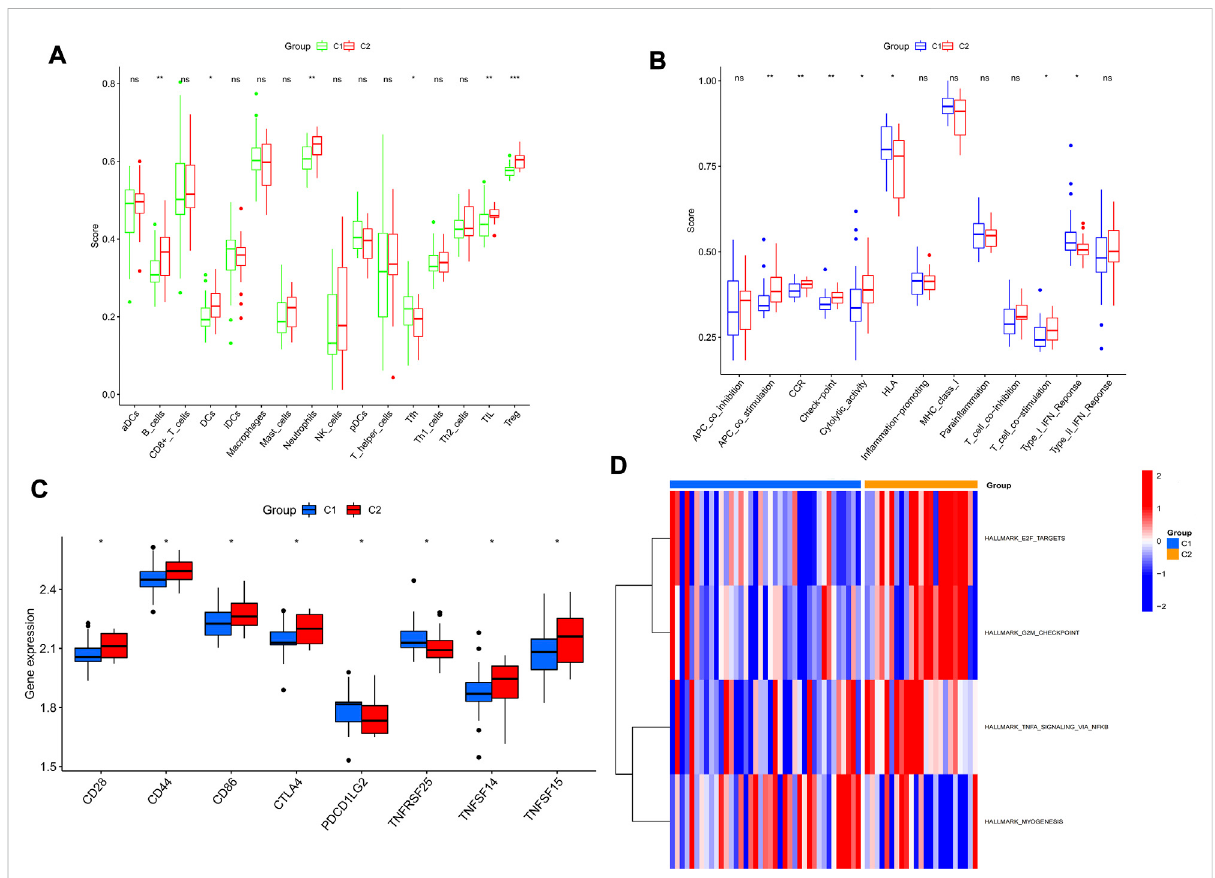
FIGURE 7 The two subtypes have different immunological features and molecular mechanisms. (A,B) Comparison of the degree of immune cell in fi ltration and immune function between the two subtypes. (C) Box plot showing the mRNA expression of signature genes in the two subtypes. (D) Heat map showing the level of enrichment of the set of signature genes in the two subtypes. * p < 0.05; ** p < 0.01 and *** p <